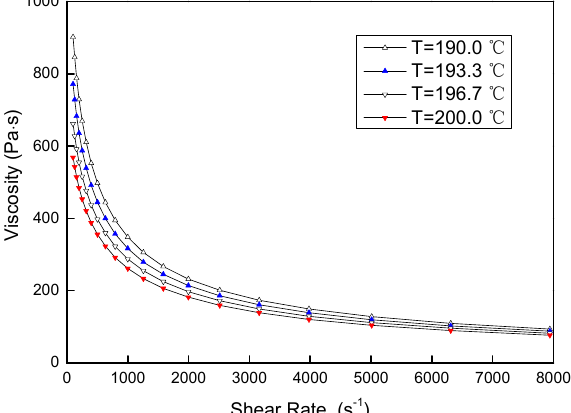
Figure 1. The rheological properties of polylactic acid (PLA).